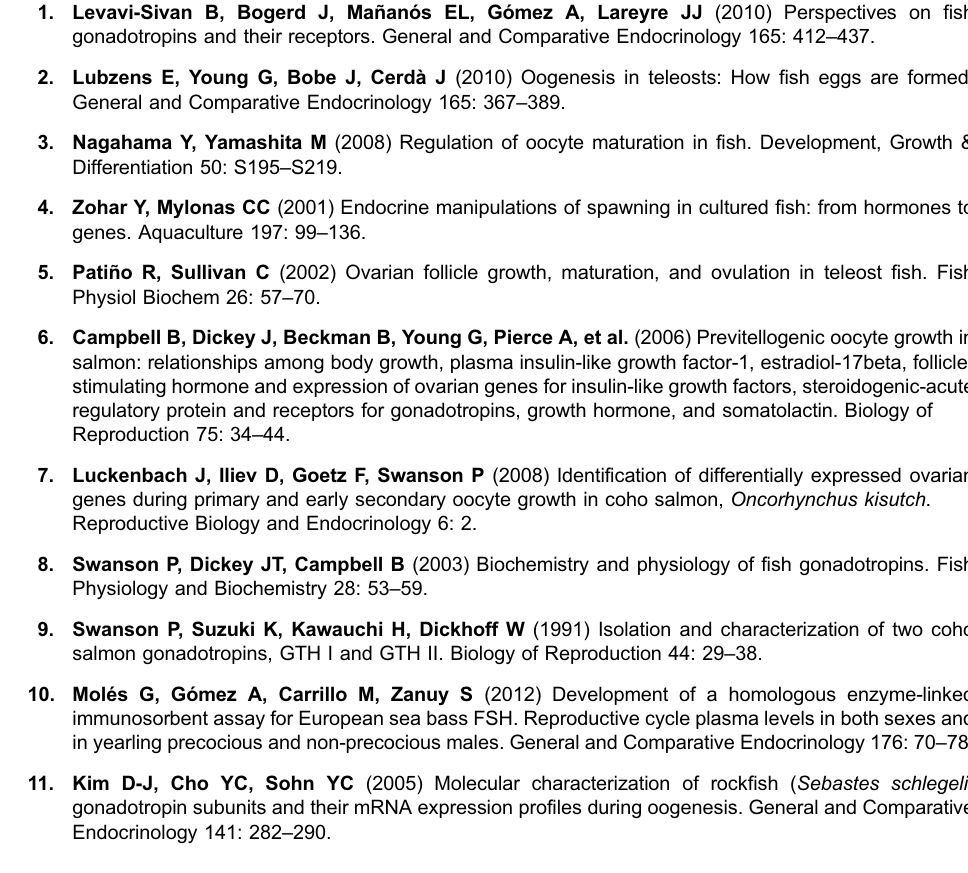
S1 Figure. Relative expression of reference genes and their geometric mean during major stages of oogenesis in coho salmon. Messenger RNA levels were analyzed by qPCR. PN, perinucleolus stage follicles; CA, cortical alveolus stage follicles; LD, lipid droplet stage follicles; VIT, mid-vitellogenic stage follicles; MAT, postvitellogenic/preovulatory stage follicles. Bars not sharing the same letter are significantly different (P , 0.05; n 5 4 fish/stage for PN-, CA-, LD-, and VIT- stages, n 5 3 fish for MAT-stage, mean ¡ SEM).